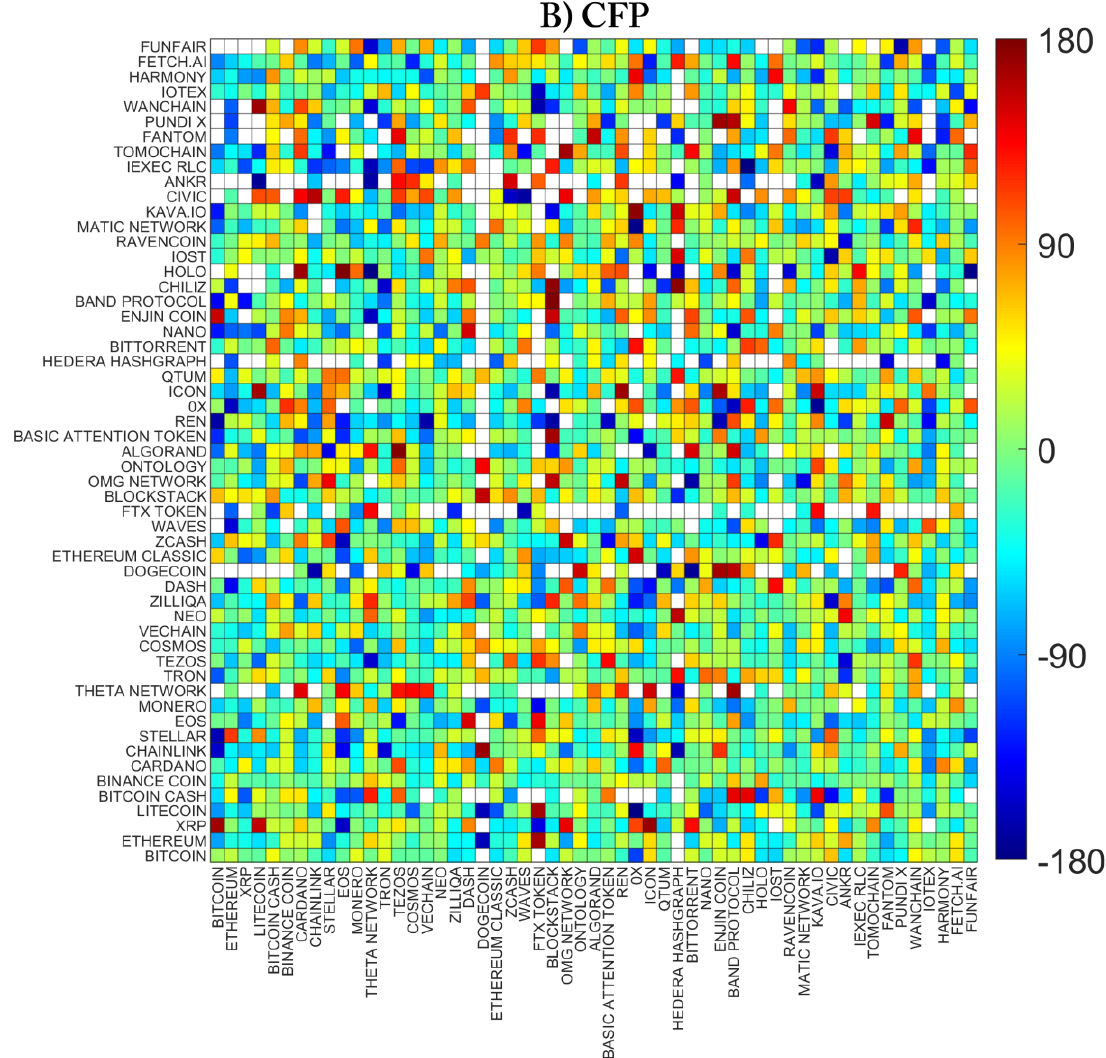
Fig. 4B. Mean pair-wise cross-frequency coupling phase (CFP). Each pixel value corresponds to the mean of the phases of all significant CFC values for each pair of cryptocurrencies. Phase values are in degrees and range from -180 to +180. (X:Y = subharmonic coupling; Y:X = harmonic